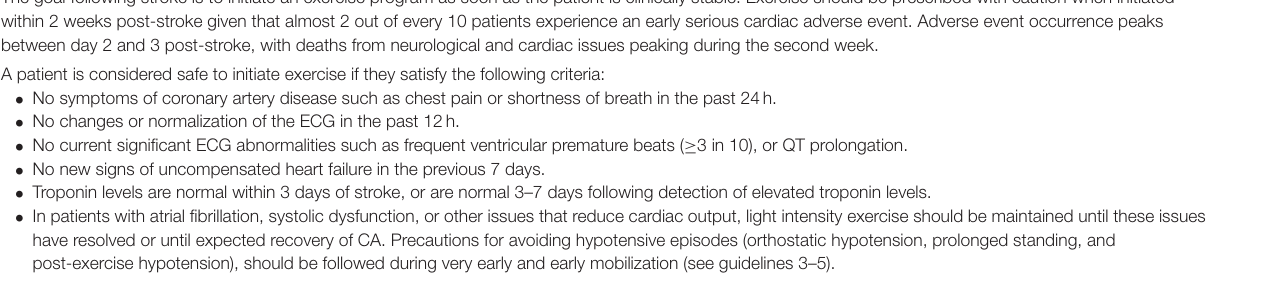
TABLE 3 | Guideline 2.0: Cardiac screening criteria. The goal following stroke is to initiate an exercise program as soon as the patient is clinically stable. Exercise should be prescribed with caution when initiated within 2 weeks post-stroke given that almost 2 out of every 10 patients experience an early serious cardiac adverse event. Adverse event occurrence peaks between day 2 and 3 post-stroke, with deaths from neurological and cardiac issues peaking during the second